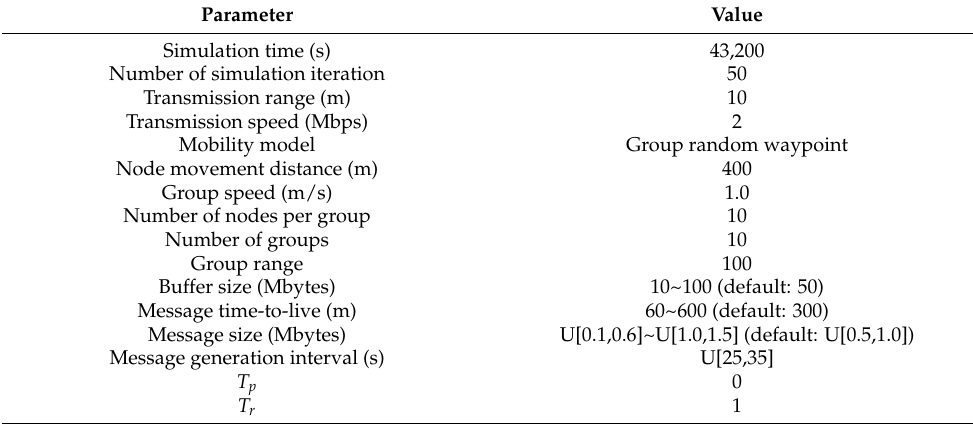
Table 3. Parameter values.